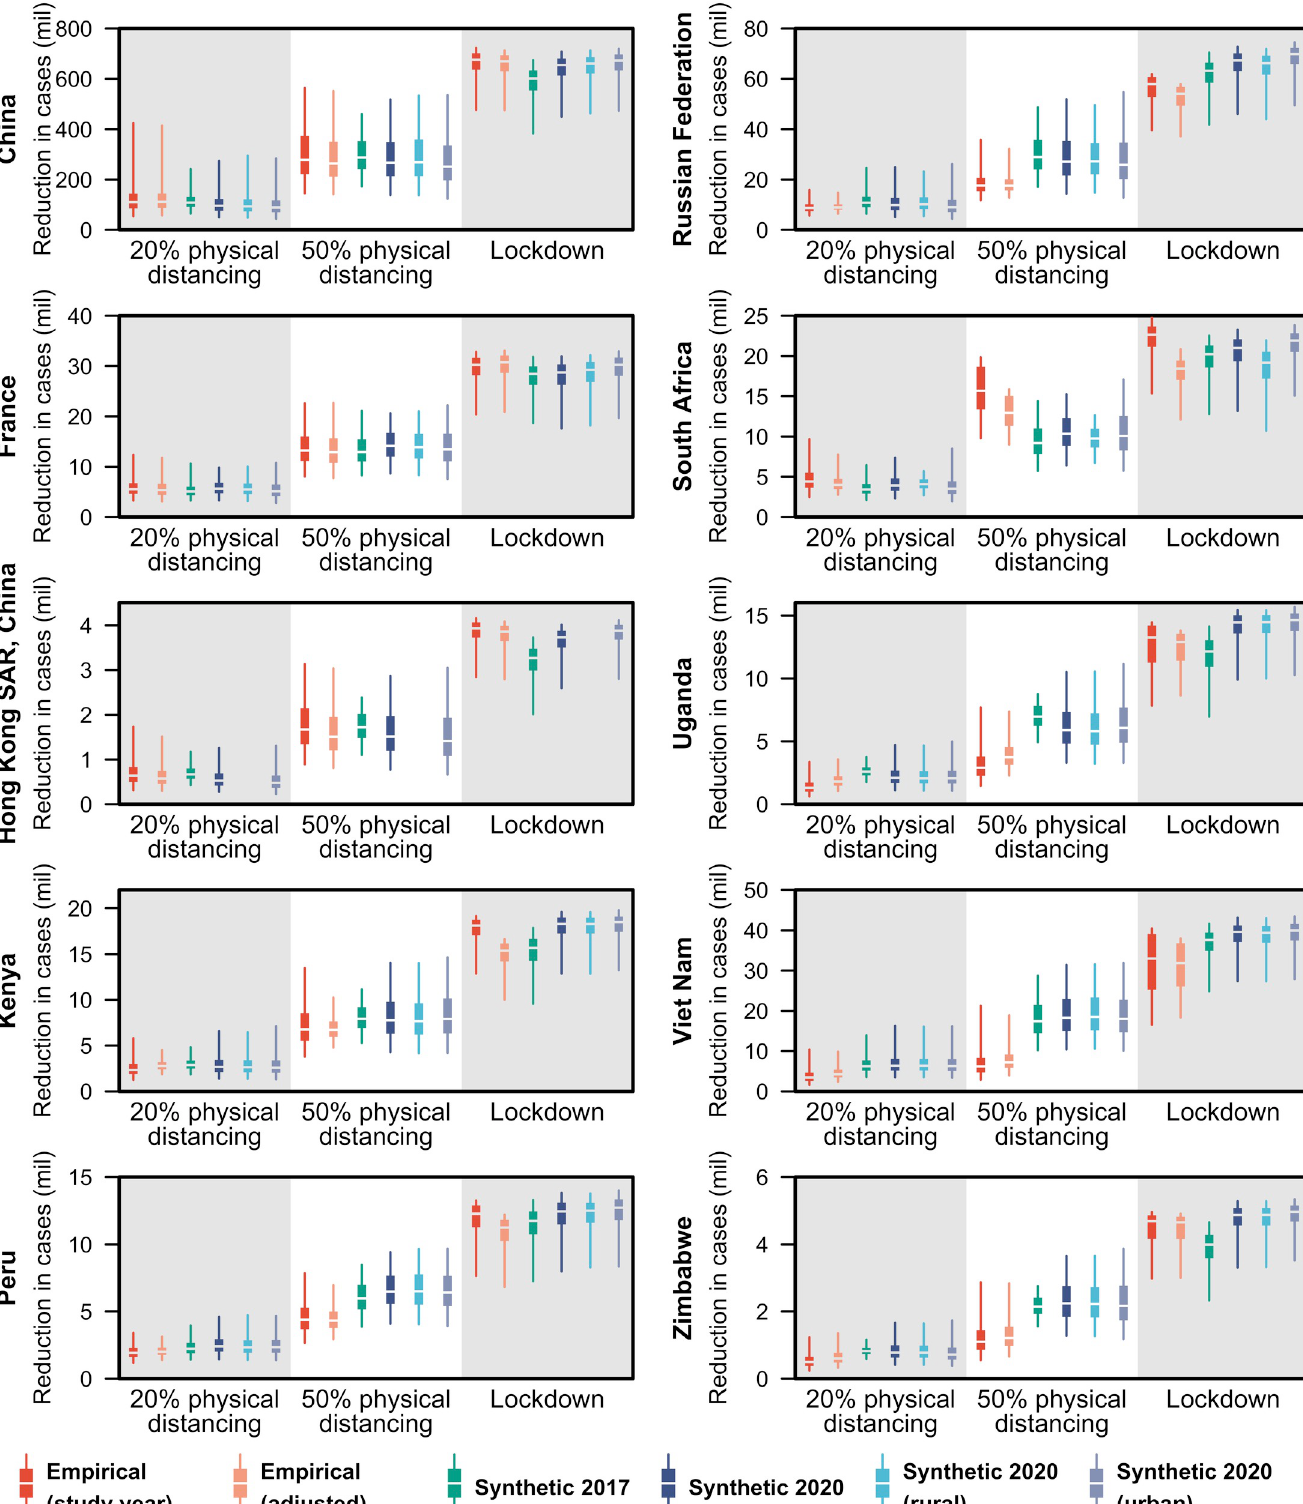
Fig 5. Reduction in cases due to interventions in models of COVID-19 epidemics under three intervention scenarios in ten geographical regions using the empirical and synthetic matrices. The reduction in cases in each of the three intervention scenario—20% physical distancing, 50% physical distancing, and lockdown